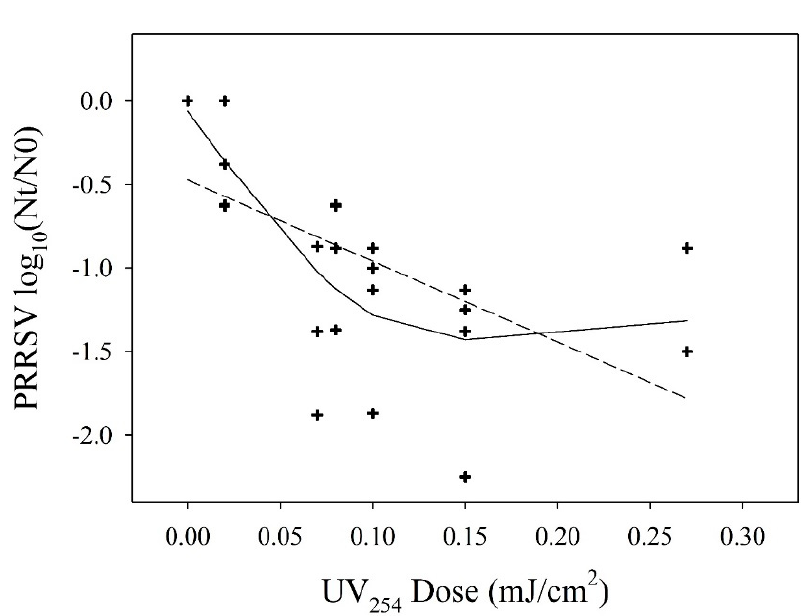
Figure A1. UV-C (254 nm) treatment inactivation curve on aerosolized PRRSV. One-stage (dashed line) and two-stage (solid line) inactivation curves were drawn. PRRSV survival is expressed as log 10 (N t /N 0 ), not as a percentage (%) as shown in Figure 2.